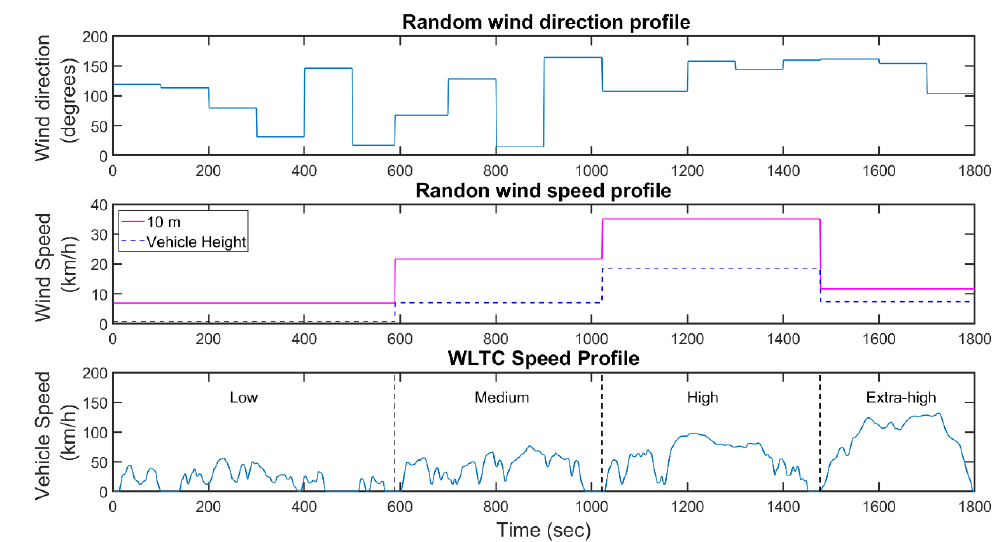
Figure 3. Random WLTC wind profile.